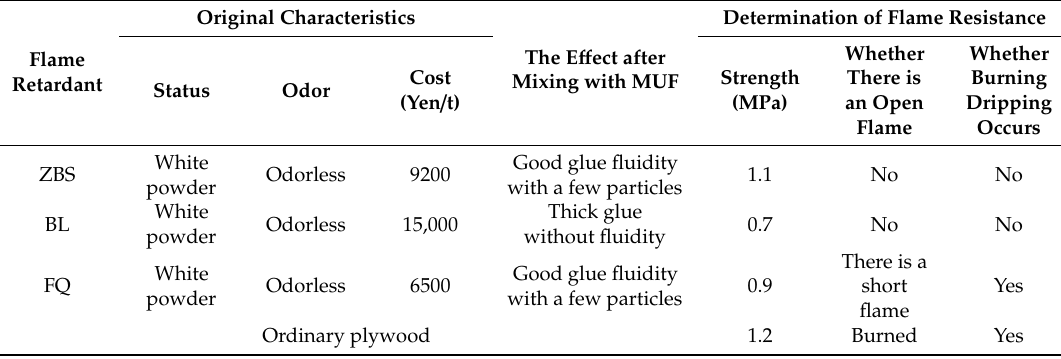
Table 3. Characteristics of di ff erent flame retardants and their e ff ects after being formulated with adhesives. MUF: melamine-modified urea-formaldehyde